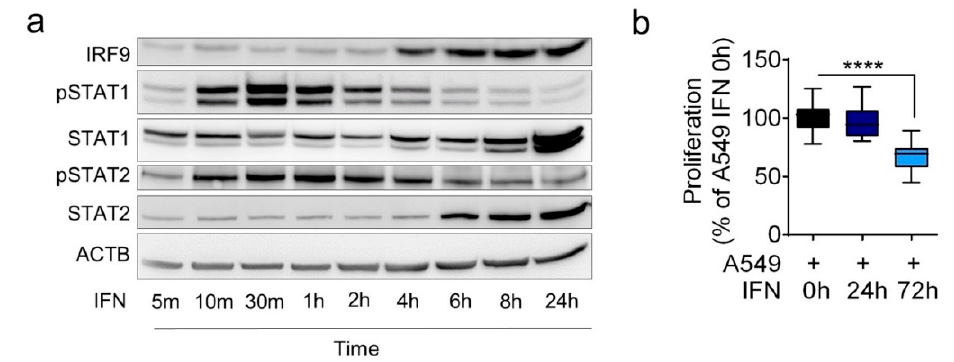
Figure 2. IRF9 is expressed upon IFN stimulation and regulates the proliferative behavior of LUAD cells. Adenocarcinoma A549 cells were treated with 100 U/mL of type I IFN for the indicated time period to evaluate ( a ) intracellular protein levels and ( b ) proliferation as a percentage of the control ( n = 3). Data are expressed as means ± standard error of the mean. Analysis was performed using one-way analysis of variance with Welch’s t -test: **** p < 0.0001 ( n =